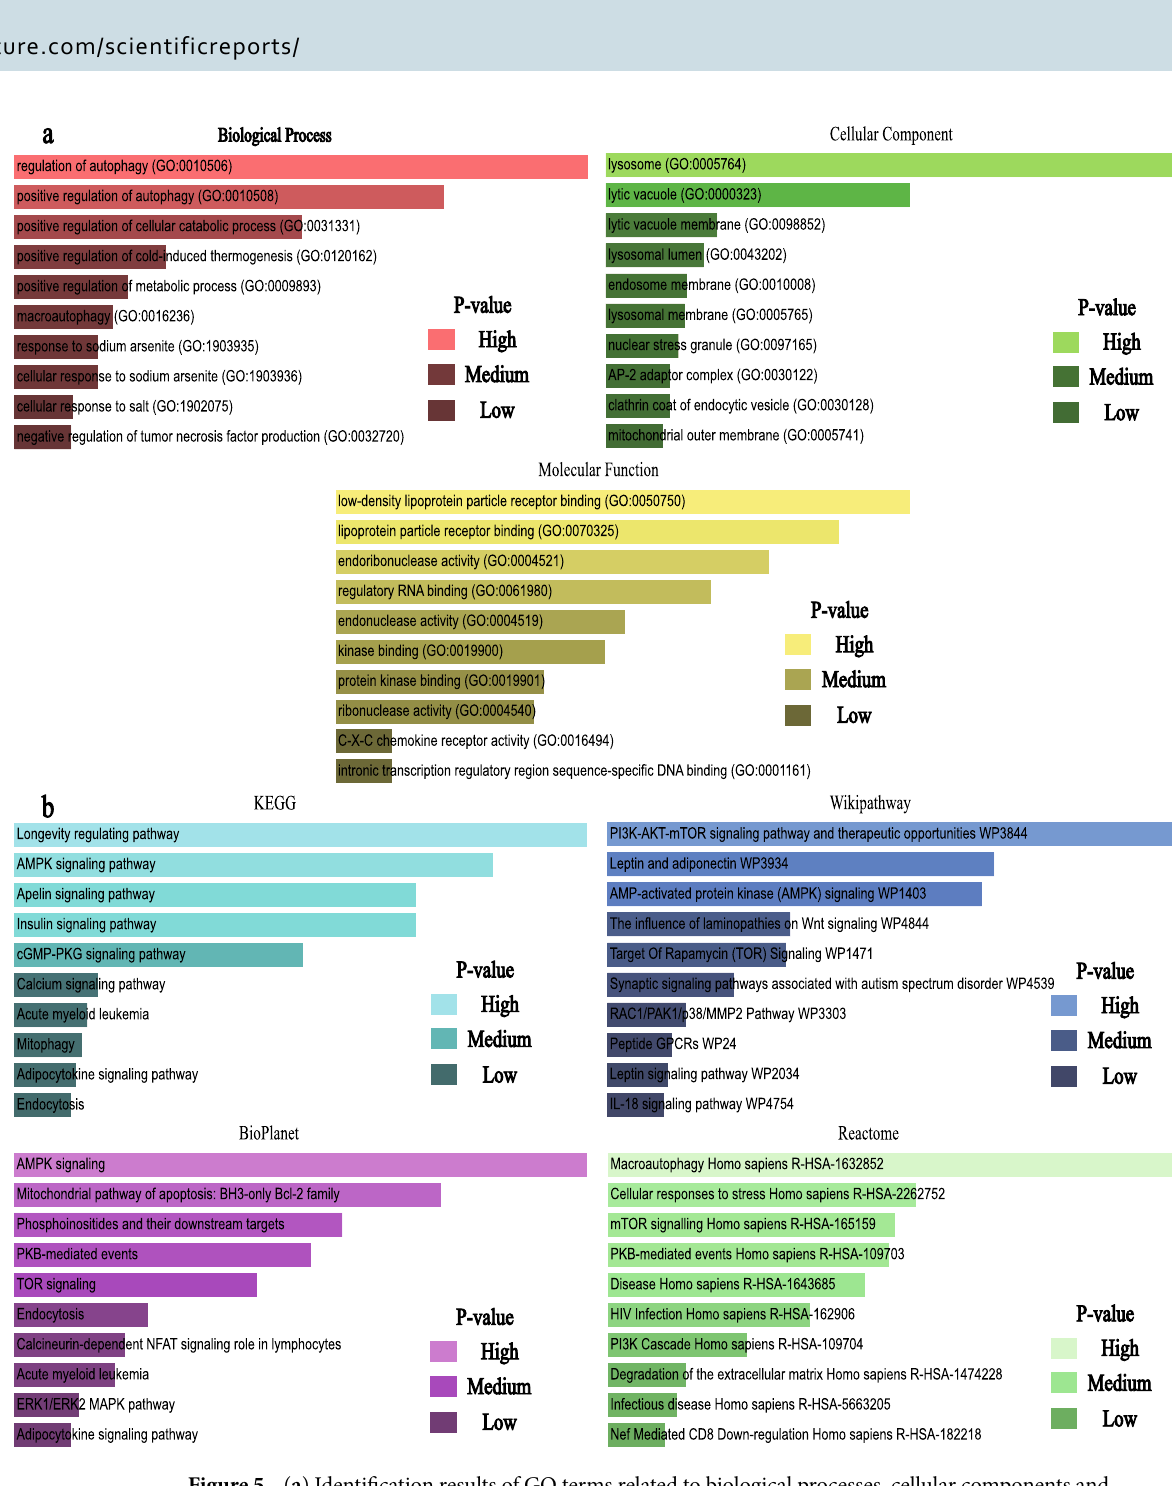
Figure 5. ( a ) Identification results of GO terms related to biological processes, cellular components and molecular functions based on gene enrichment analysis. Higher p value indicated a higher number of genes involved in this GO ontology. ( b ) Identification of results from combined multi-pathway analysis by KEGG, WikiPathways, BioPlanet and